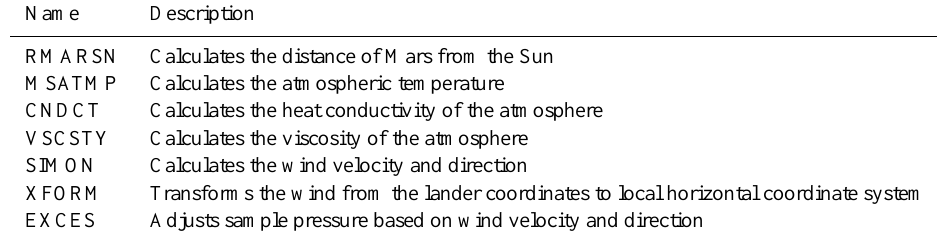
Table 5. Wind and temperature value calculation (SANMET WNDTMP).